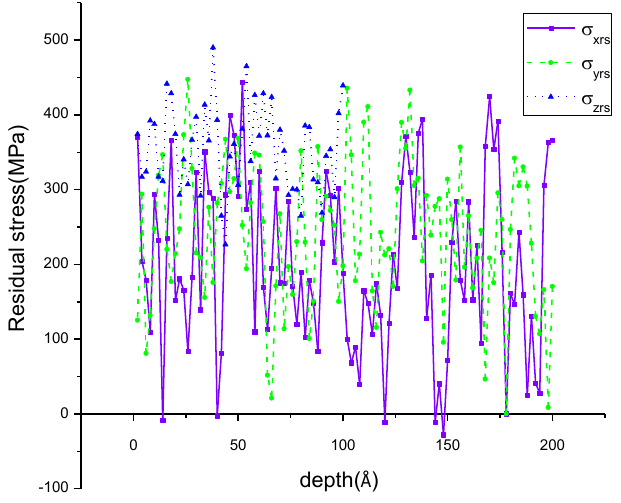
Figure 3. The residual stress in the X, Y, Z directions after prepressing.